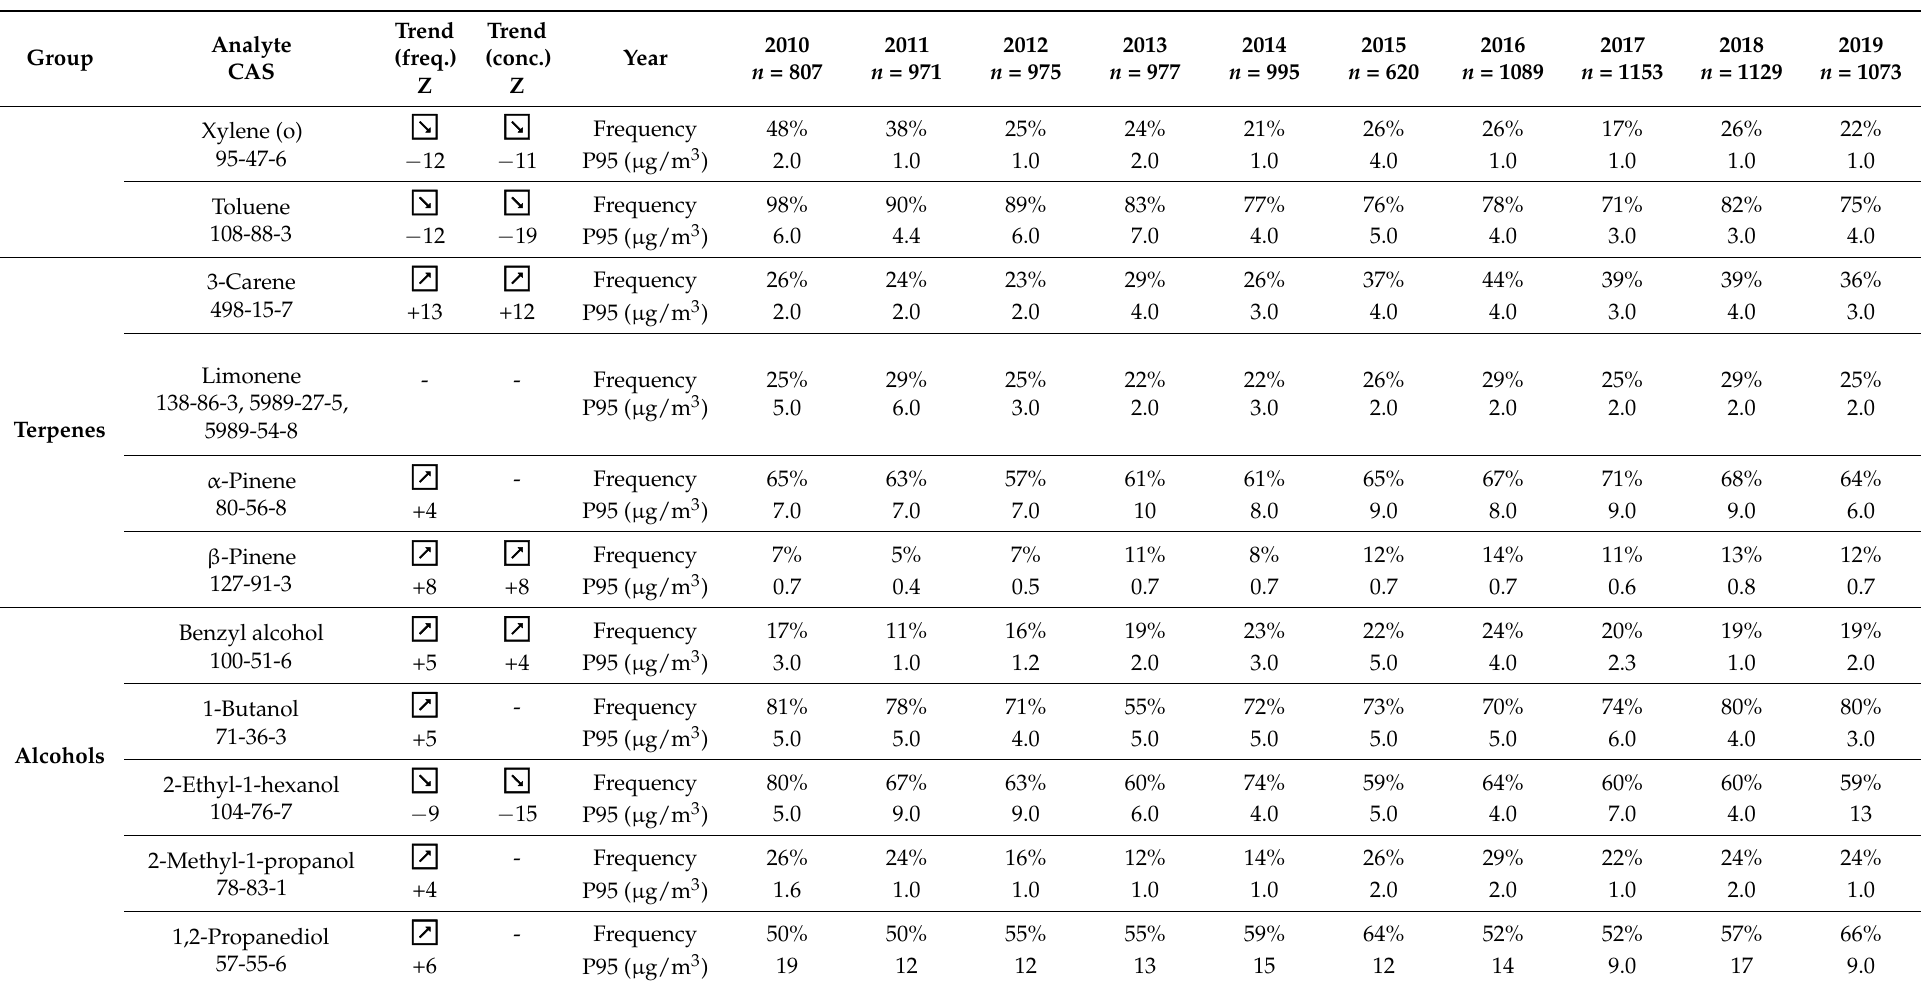
Table 4. Annual statistics of VOCs (a) and formaldehyde (b) during the ten-year study period 2010–2019. Frequency trend was tested using Somer’s D test, where input data were binomial (measurement result either >LOQ or <LOQ). Concentration trend was tested using Somer’s D test, where input data comprised all measured concentration values. Here, measurement results that were <LOQ were replaced by a concentration value LOQ/2. Trends indicated by downward or upward arrow symbol were statistically significant ( p < 0.0001) and had ǀ Z ǀ ≥ 4. Z values shown below arrow symbols indicate direction and steepness of trend.